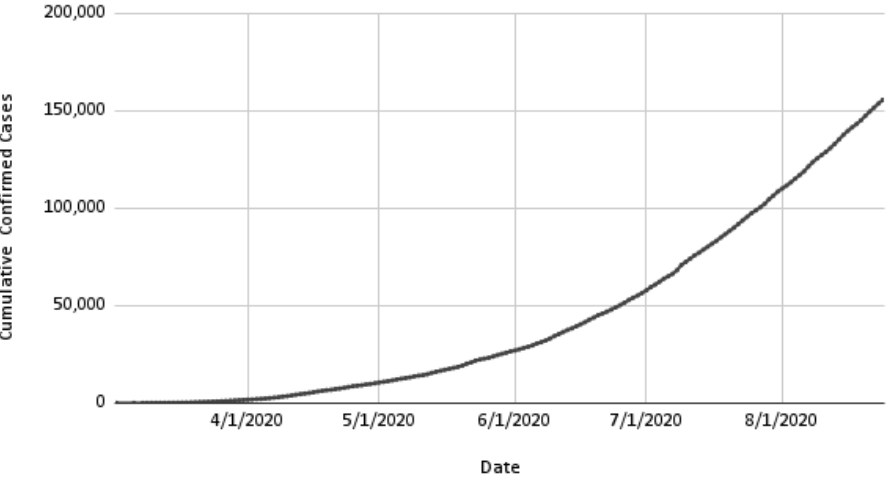
Figure 1. Cumulative confirmed cases of COVID-19 in Indonesia.